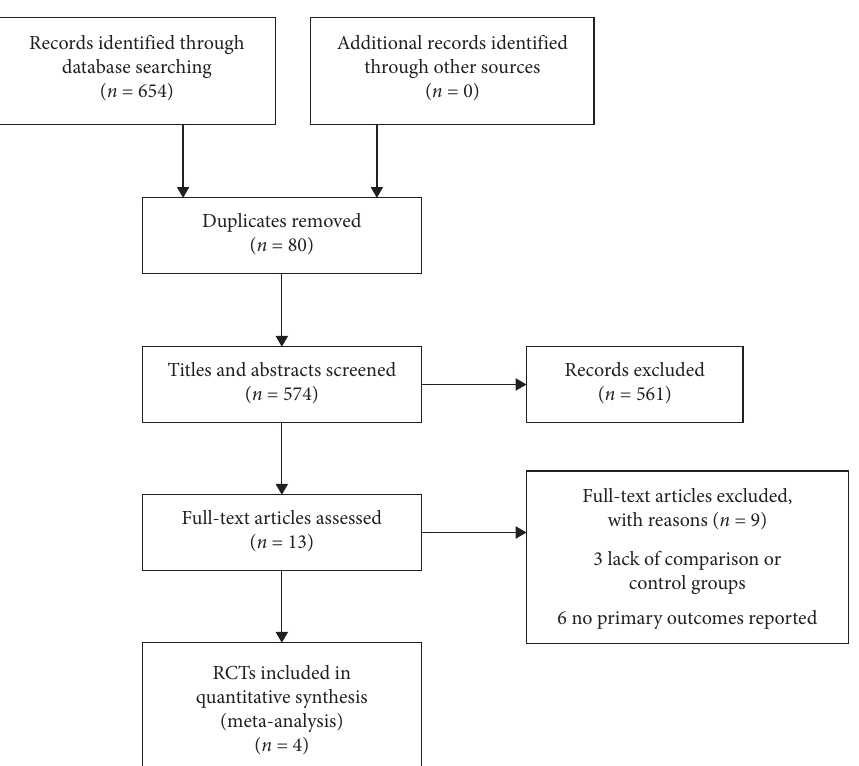
Figure 1: Flow diagram of the study selection